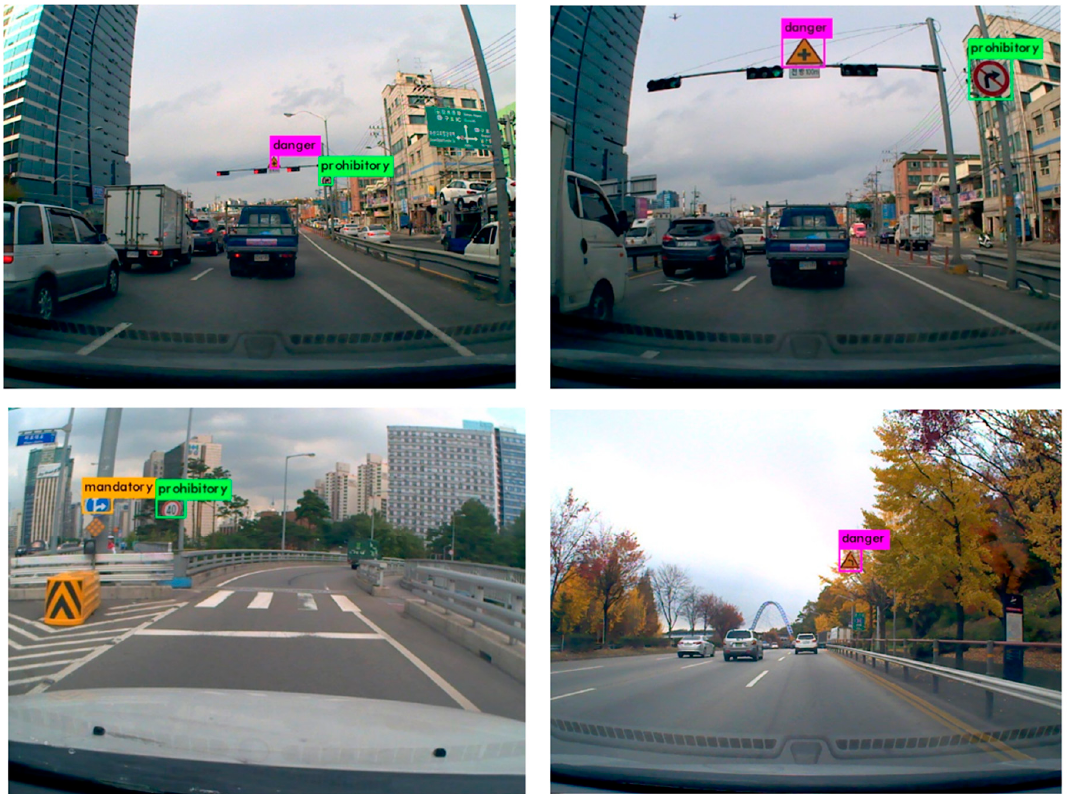
Figure 8. Detection examples on Korean Traffic Sign Dataset.